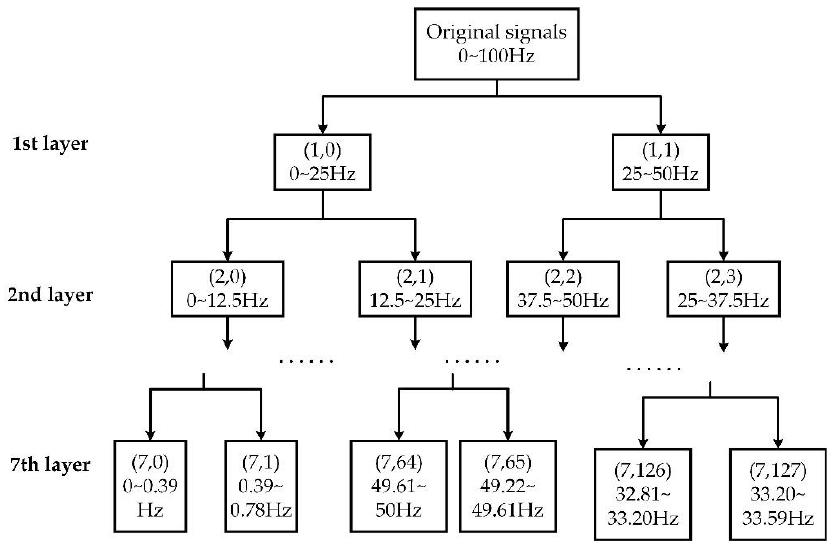
Figure 2. The wavelet packet tree applied for signal processing.